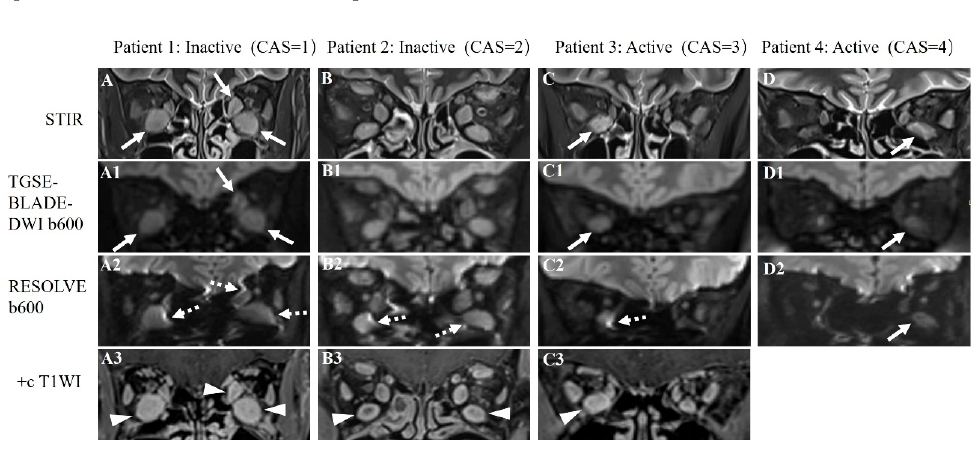
Table 1. Subjective image scores of EOMs for the 35 enrolled TAO patients [M( Q 1 ,Q 3 )]. EOMs RESOLVE TGSE-BLADE-DWI Z p Right superior rectus 2(1,3) 2(2,3) − 3.177 0.001 Right inferior rectus 1(1,2) Right medial rectus 1(1,2) 3(2,3) Right lateral rectus Left inferior rectus